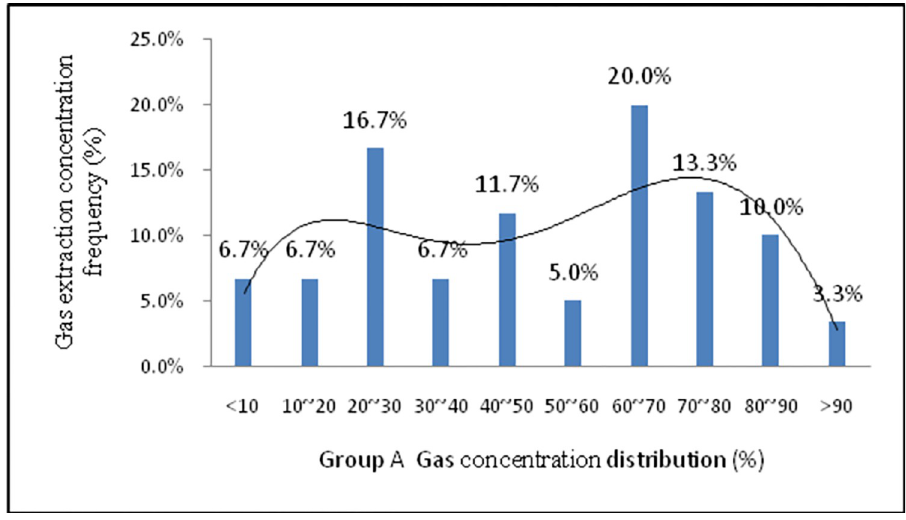
Fig 16. Gas concentration frequency distribution histogram Group